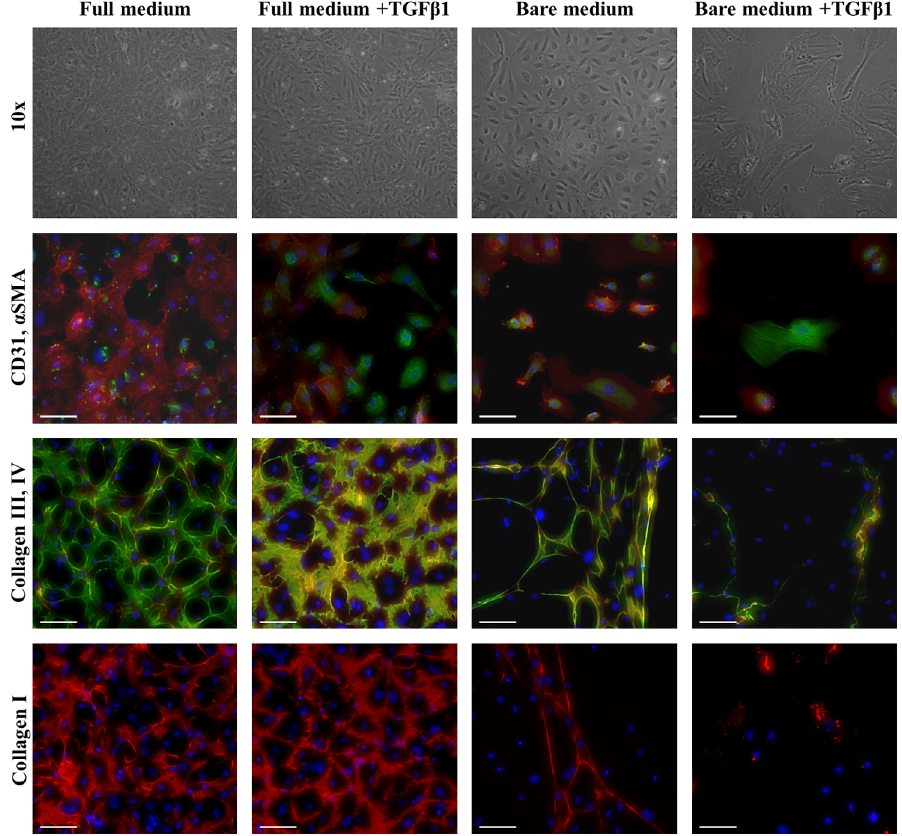
Figure 6. Phase contrast and immunofluorescent images of ECFCs on coverglasses in different media. Phase contrast pictures, after 14 days of culture, at 10 6 magnification show the complete change in ECFC morphology in bare medium + TGF b 1, where cells are elongated and they have lost the cobblestone morphology, still retained by ECFCs cultured in the other media. Immunostaining for CD31 (red), a SMA (green) and DAPI (blue), confirmed the differences observed by optical imaging, with loss of CD31 in part of the cells cultured in full medium + TGF b 1 and bare medium + TGF b 1, and a SMA stress fibers only detected in bare medium + TGF b 1. Immunostaining for collagen type III (green), IV (red) and DAPI (blue) showed a decrease in matrix production in bare medium with or without TGF b 1. This result was also confirmed for collagen type I (red). The scalebar represents 100 m m. Figure S1 Characterization of ECFCs by (A) flow cytometry of cell type markers and microscopy (B). ECFCs do not express the leukocyte markers CD14 or CD45, retain some CD34 expression but not CD133, and express the endothelial markers CD105 (Endoglin), CD31 (PECAM), CD144 (VE-Cadherin) and KDR (VEGFR-2). A monolayer of ECFCs shows a typical cobblestone pattern in vitro (magnification 4x). (TIF) Figure S2 qPCR of ECFCs cultured in 3D in all medium groups under static or cyclic strain. Expression of EndoMT genes is shown relative to ECFCs before seeding into the 3D gels. Medium groups and static or cyclic strain did not result in any